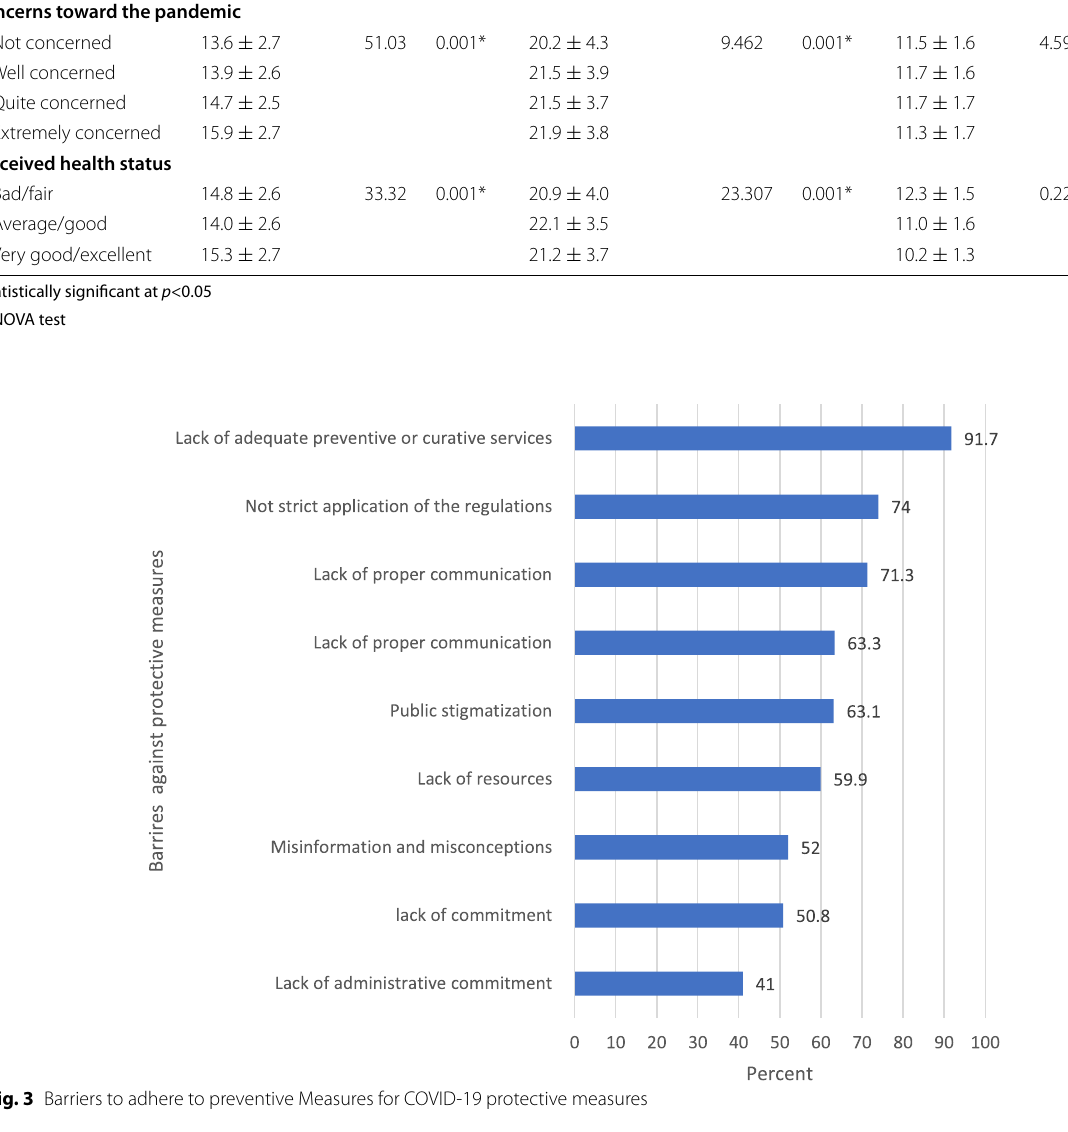
Fig. 3 Barriers to adhere to preventive Measures for COVID-19 protective